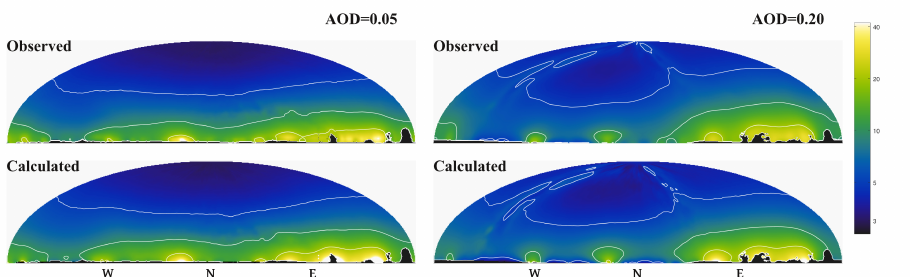
Figure 10. Comparison of the observations (bottom) with the models (top) The areosol optical depth (AOD) used for the Monte Carlo simulation is indicated at the top of the figure.